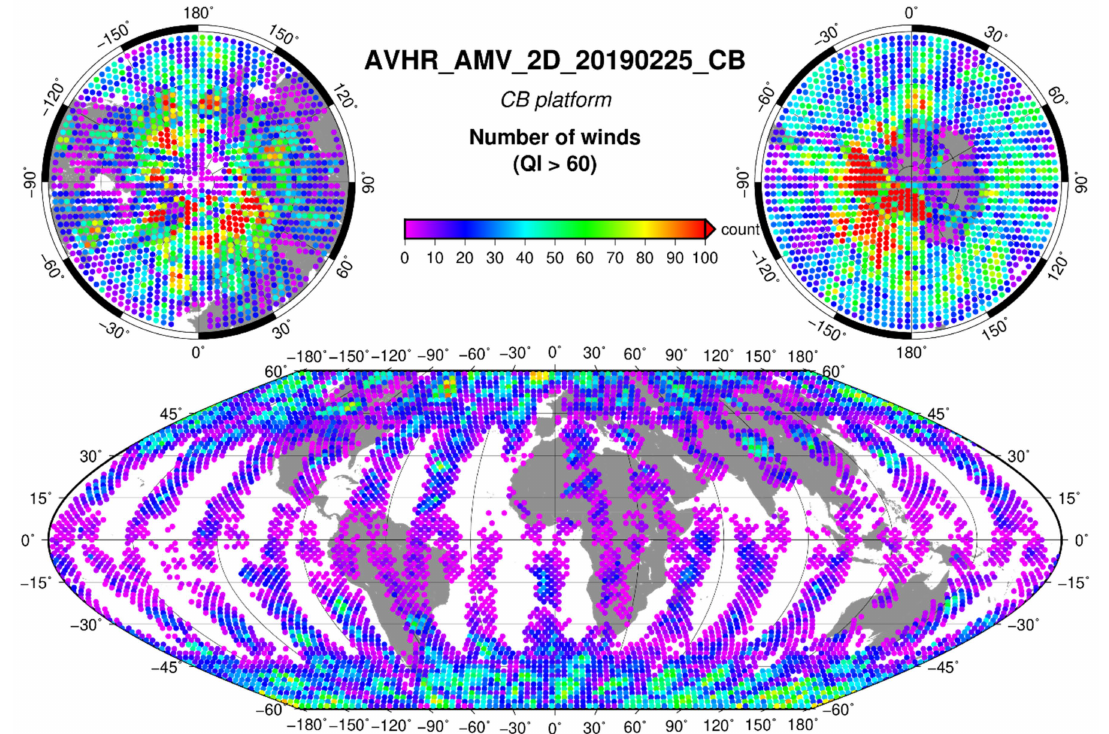
Figure 5. Dual-Metop wind production considering pairs B–C (top) and C–B (bottom) on 25 February 2019, illustrating the asymmetric production of the two